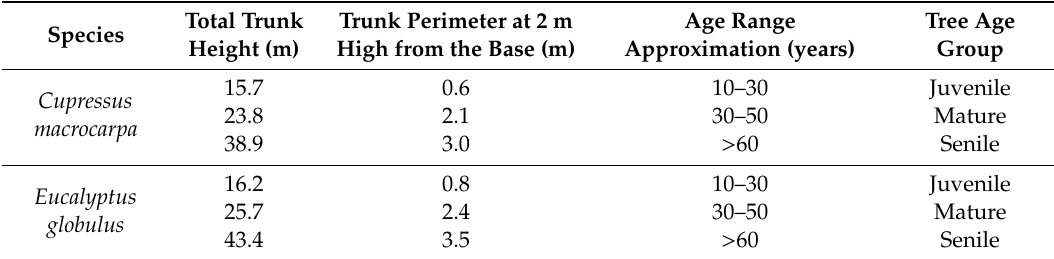
Table 1. Age estimation derived from the height-perimeter relationship of the trees.